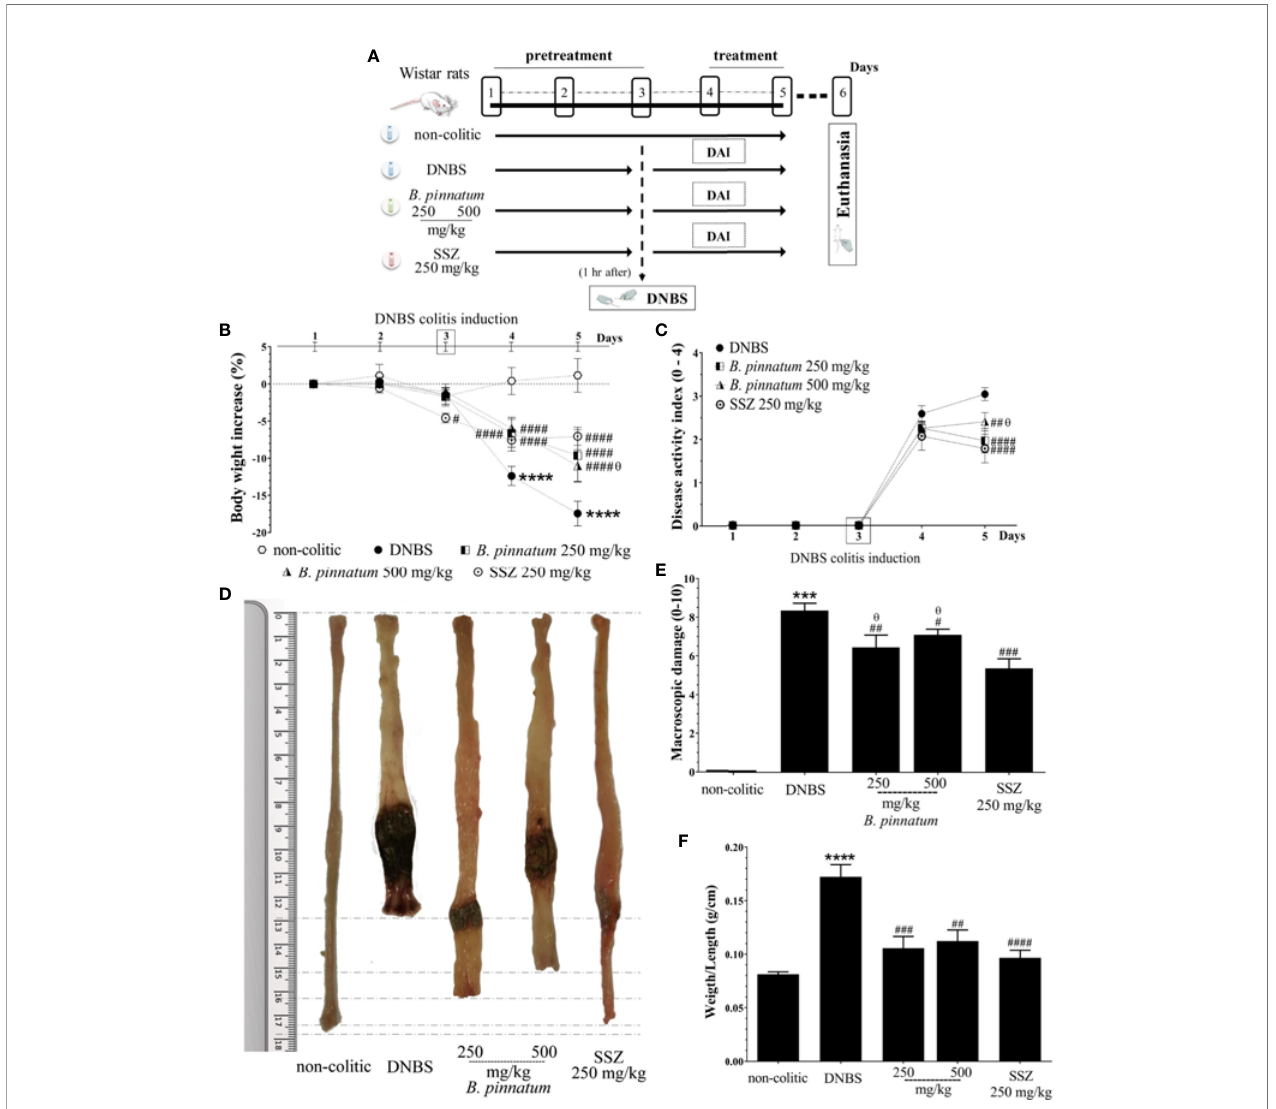
FIGURE 2 | 2.4-dinitrobenzene sulfonic acid (DNBS) – induced colitis experimental design (A) and effects of treatments with hydroethanolic extract from B. pinnatum leaf (HEBP) on weight loss (B) , damage of the colon (C) , macroscopic damage score (MDS) (D) , weight/length ratio (E) , and disease activity index (DAI) (F) . Data (n = 8) are presented as mean ± standard error from the mean. *** p < 0.001, **** p < 0.0001 compared with non-colitic group; # p < 0.01, ### p < 0.001, #### p < 0.0001 compared with DNBS group; q p < 0.05 compared with SSZ 250 mg/kg